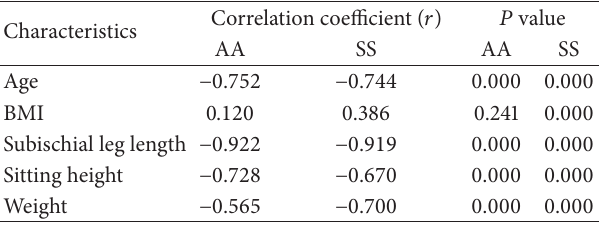
Table 3: The Pearson correlation of Cormic Index with other anthropometrics and age.